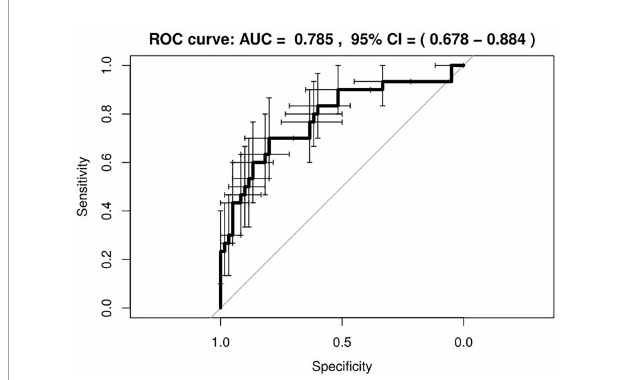
FIGURE5 Receiver operating characteristic (ROC) curve of the developed radiomic model. The bars indicate the 95% confidence intervals (CI) for sensitivity and